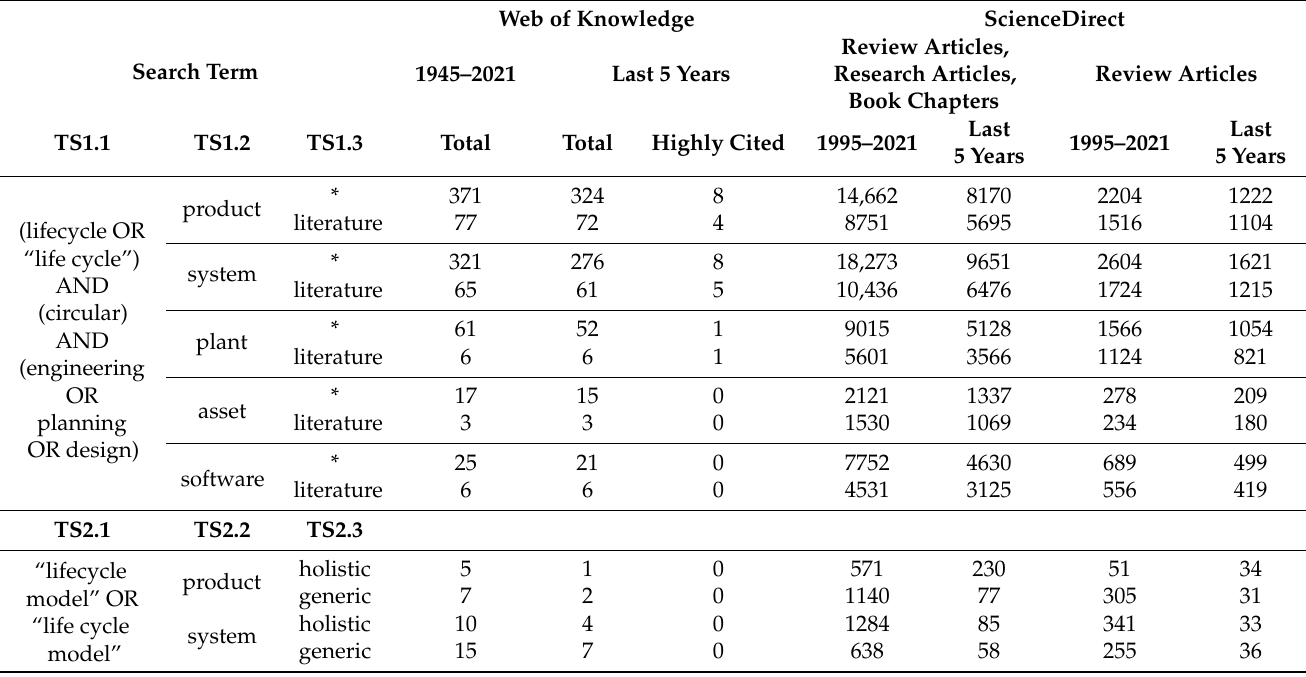
Table 1. Results of quantitative literature analysis (numbers finally updated on 2 May 2021, asterisk means wildcard).